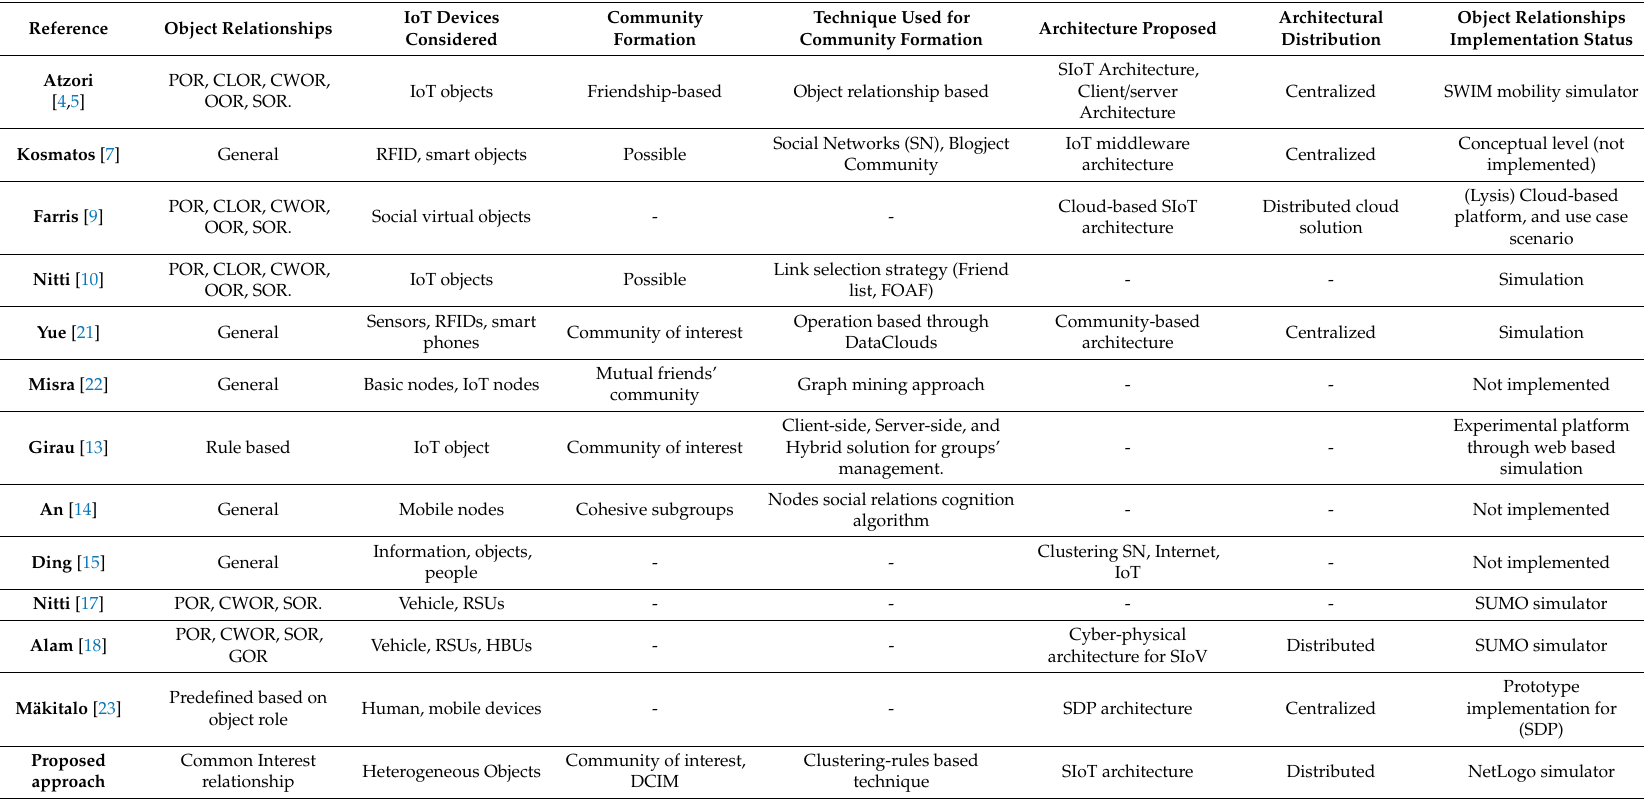
Table 1. Main di ff erences between Dynamic Community of Interest Model (DCIM) and other